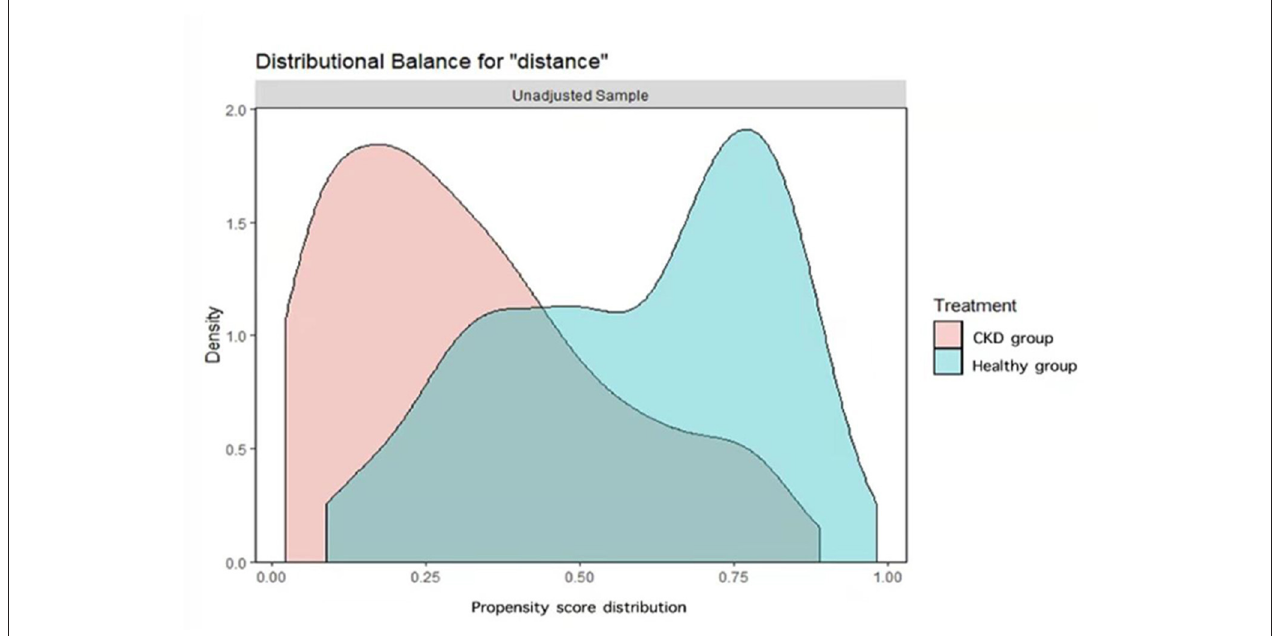
FIGURE 1 | Overlay of Kernel density distributions of propensity scores for caregivers of children with CKD and caregivers of healthy children before propensity score matching.